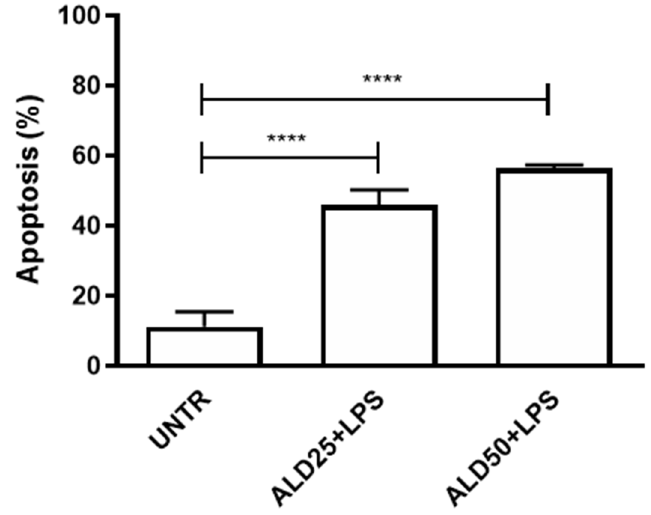
Figure 2. Analysis of RAW 264.7 apoptosis levels after treatment with two different ALD concentrations, 25 µ M and 50 µ M) plus LPS (10 µ g/mL). Results are indicated as mean ± standard deviation of independent replicates, analyzed with ANOVA and corrected with Bonferroni post-test (**** p < 0.0001). UNTR: untreated.